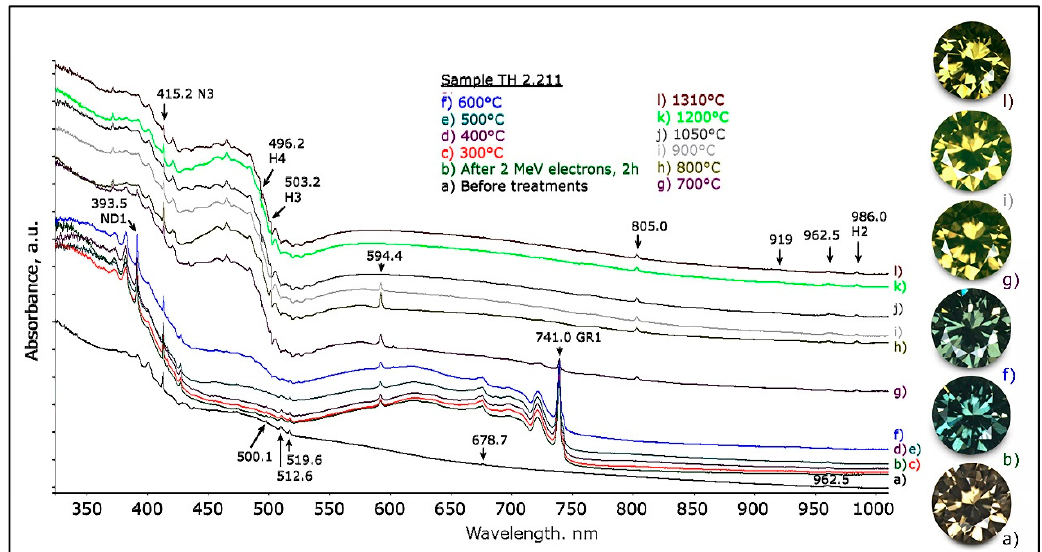
Figure 31. The evolution of the color and the UV-Vis-NIR spectra of a light brown diamond (sample TH 2.211) after 2 h of 2 MeV electron irradiation and stepwise annealing from 300 °C to 1310 °C. The stone showed the desired color changes from brown via greenish blue to greenish yellow, by formation of GR1 from irradiation and H4 plus H3 via the annealing.